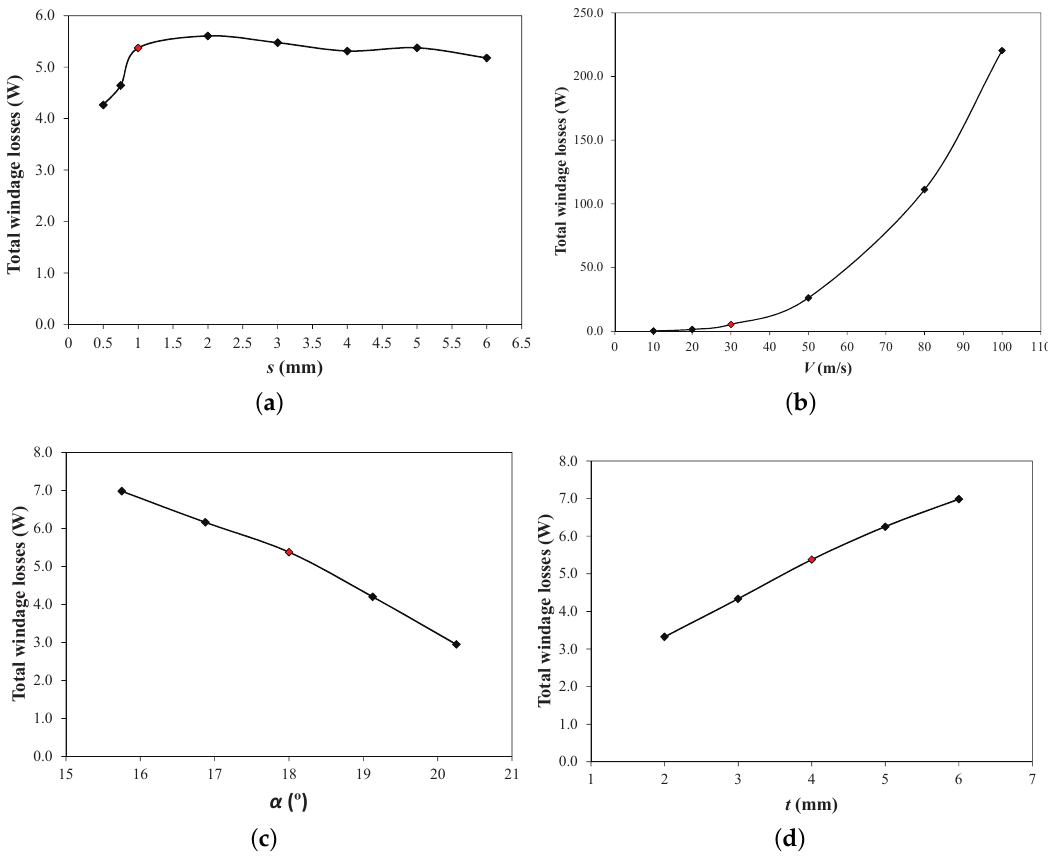
Figure 8. The influence of ( a ) gap size distance s (mm); ( b ) tip velocity of the magnets V (m/s); ( c ) magnet angle α ( ◦ ) ; and ( d ) magnet thickness t (mm) on the overall windage power losses ( W ) (reference point is highlighted with the red